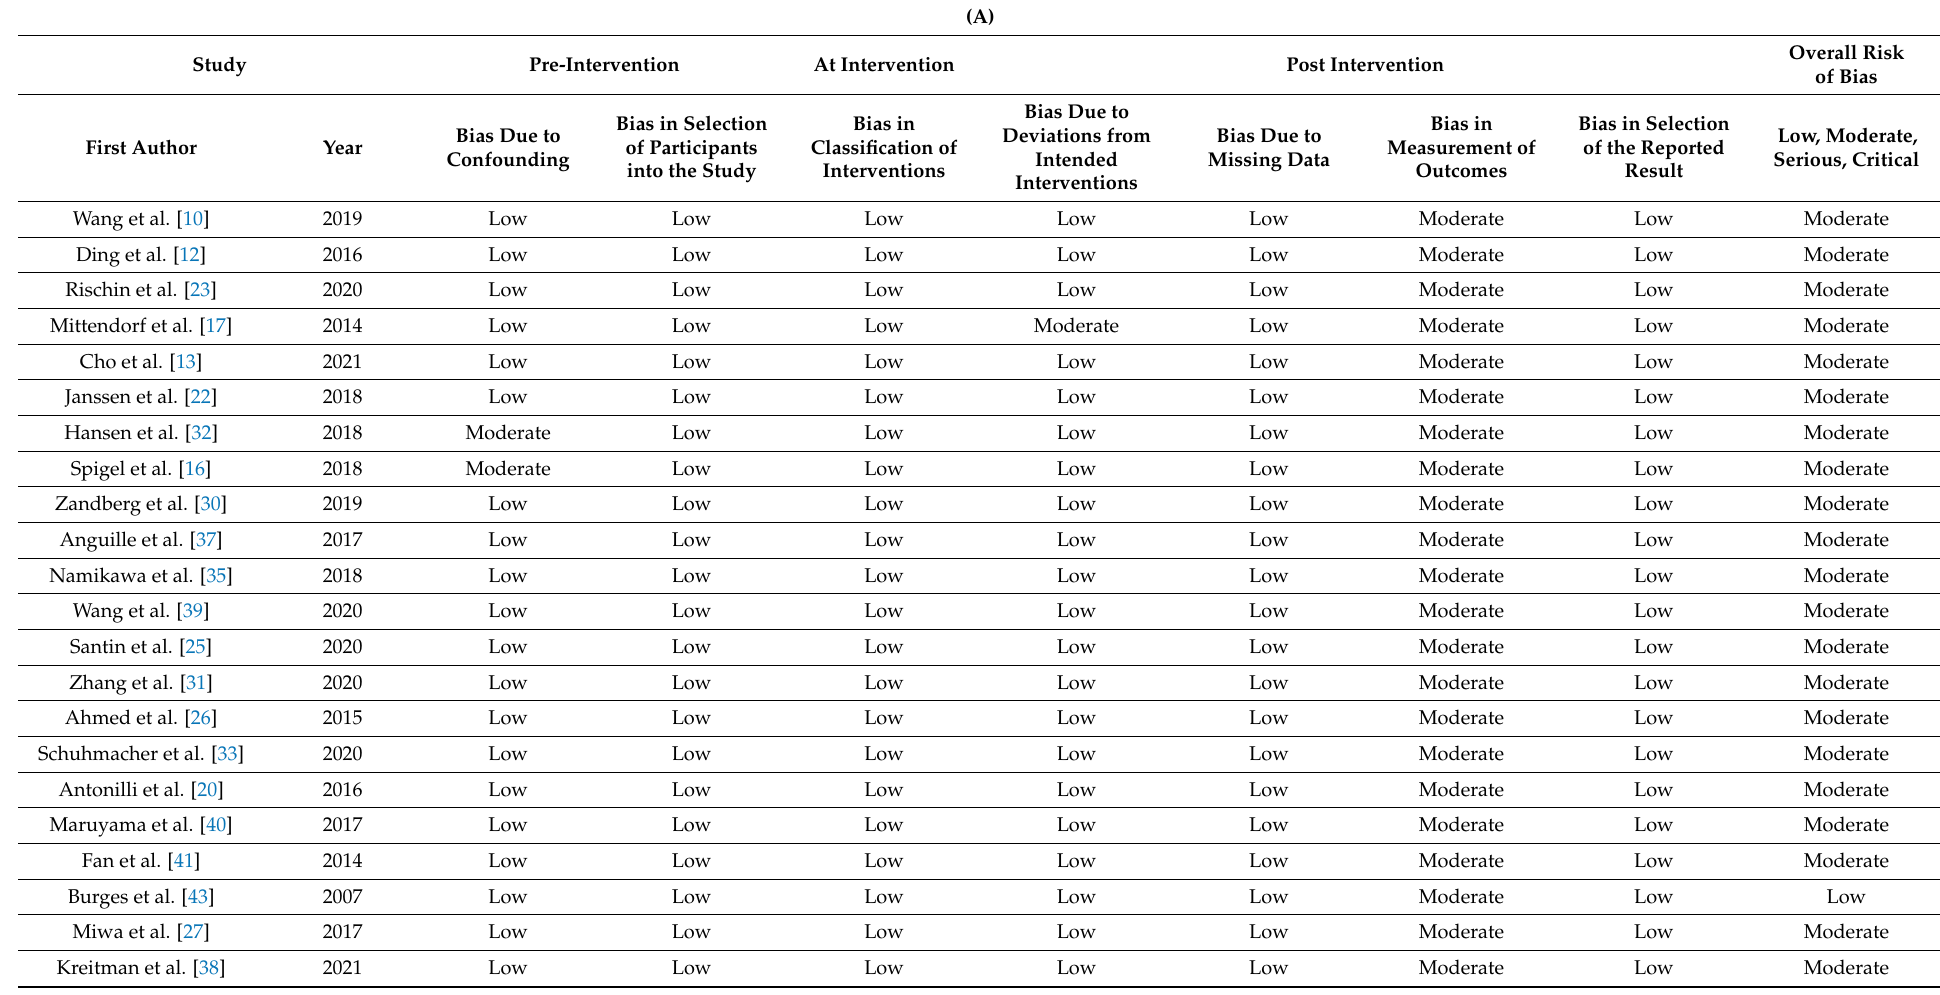
Table 2. ( A ) Risk of bias for non-randomized controlled trials. ( B ) Risk of bias for randomized controlled